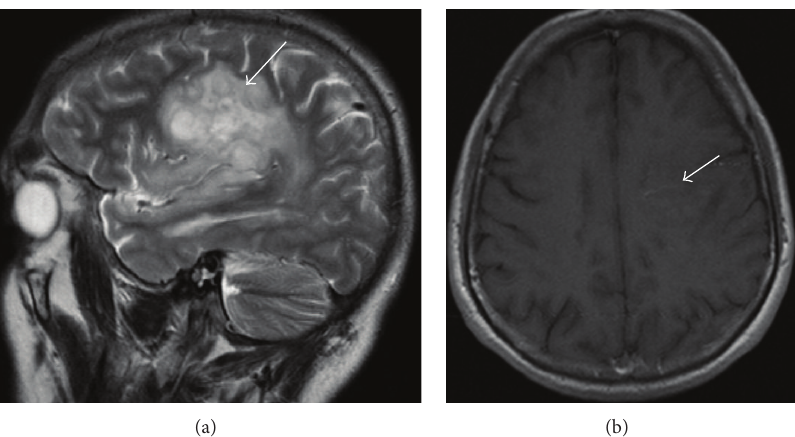
Figure 2: Cerebral MRI (2008): (a) large lesion in the left frontal lobe (large arrow). (b) Subtle contrast-enhancement (small arrow) and mass effect, suggesting an infiltrative lesion from glial series.